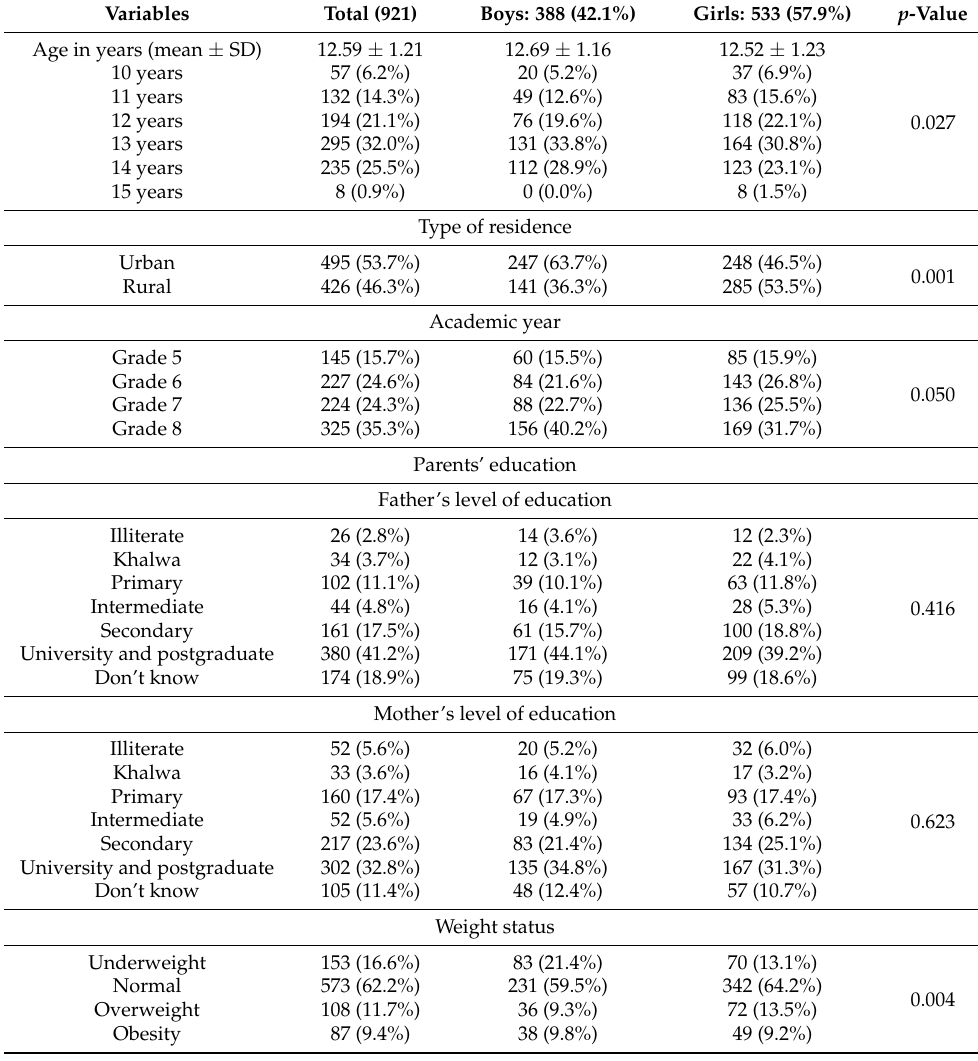
Table 1. General background characteristics of the participants based on gender.